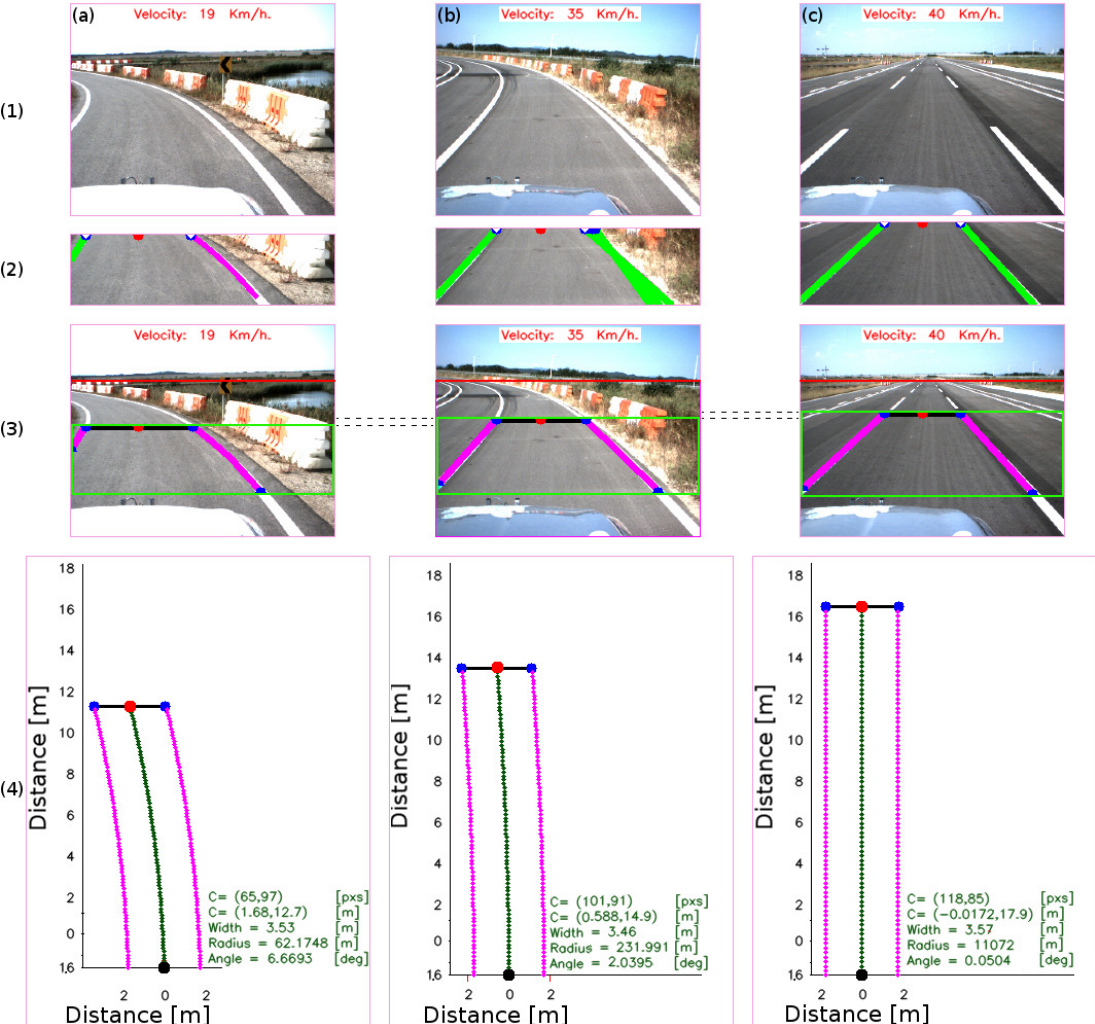
Figure 11. Lane region and parameters estimation. ( a – c ) show the estimation result of the road geometry model for a set of frames, at different speeds of the vehicle and their respective result at each step (rows 1–4). The first row shows the set of input images taken at different speeds. The second row shows the lane marking detection results (lines in green or curves in magenta ), the extracted centroid of the lane marking (circled in red ), and the ending point of the detected lane marking (circled in blue ). The small circle in white indicates the line fitting model extracted to define the lane region. The third row shows the road geometry estimation within the image. The line in black represents the lane width (in pixels), the line/curve in magenta shows the lane marking which defines the region located in front of the vehicle. It can be noticed that the lane region increases as the speed of the vehicle increases, see the gaps between images (the dashed line in black between images). The fourth row shows the lane region detection in the real world using the model shown in Figures 2 and 7. The point in red shows the estimated centroid. Points in blue show the ending point for each detected lane marking. The dashed green line shows the estimated current vehicle trajectory along the centerline of the lane between the rear-axle position and the estimated centroid of the lane (vehicle heading angle). The line in black shows the width of the lane, computed as the difference between the ending points. The region within the set of lines in magenta describes the lane region within the collision risk region estimate at each